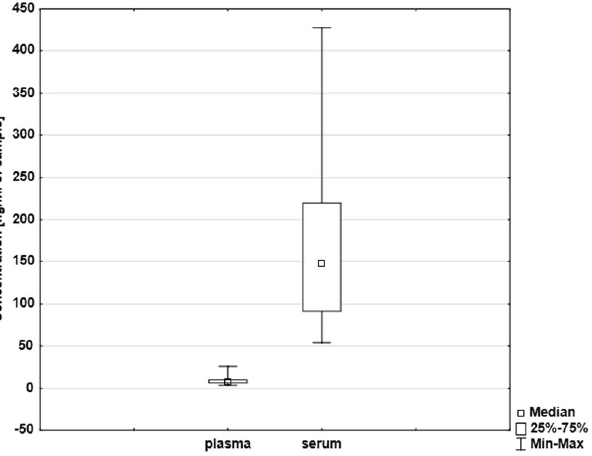
Figure 1. Box plot showing different concentrations of total cfDNA in plasma and serum samples [ng/ml] measured by qPCR for single copy gene 36B4 (n =